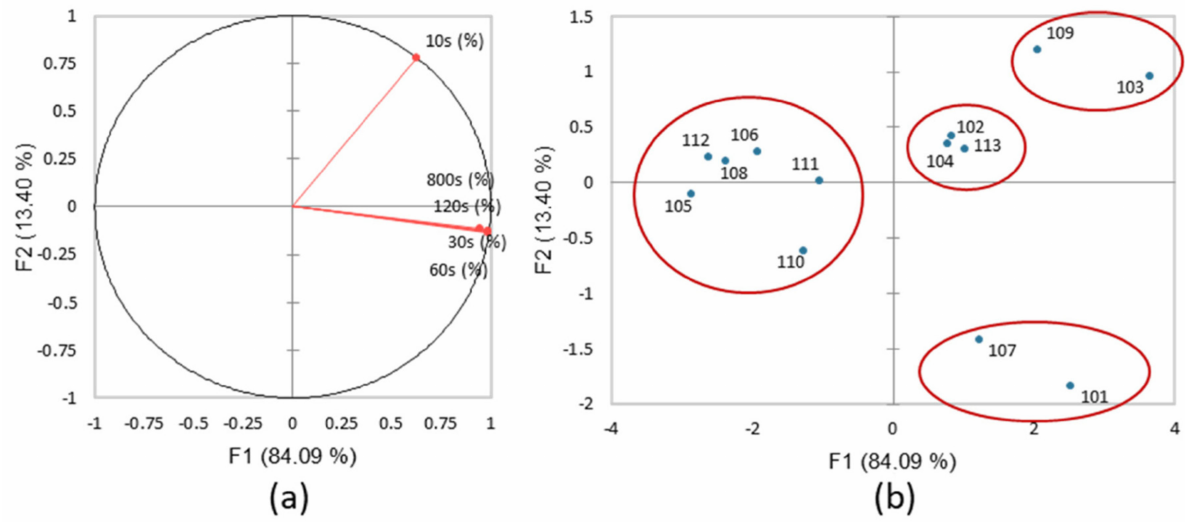
Figure 7. ( a ) PCA loading plot of the rheological parameters (variables) and ( b ) PCA loading plot of the products (individuals) for the restructuring test.